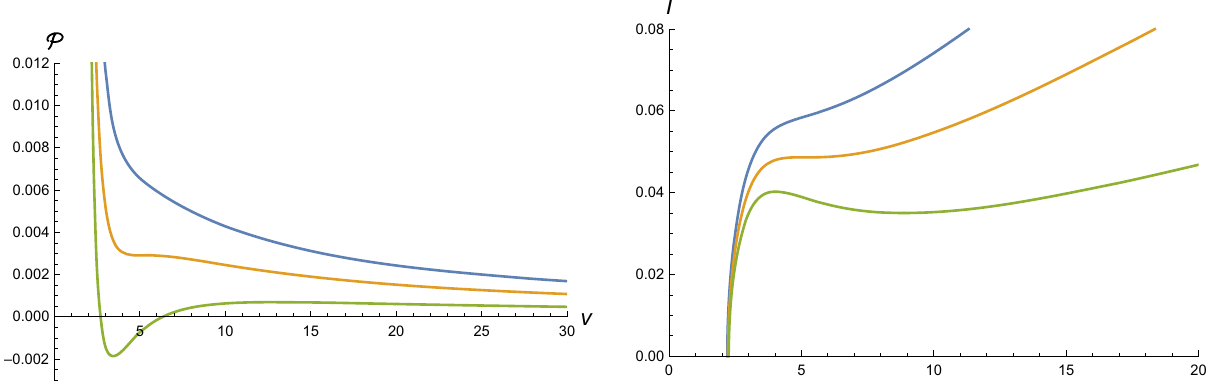
atures3 T c / 2 , T c , T c / 2 from toptobottom. Inthe T – v diagram, thelines represent isobars with pressures 3 P c / 2 , P c , P c / 2 from top to bottom